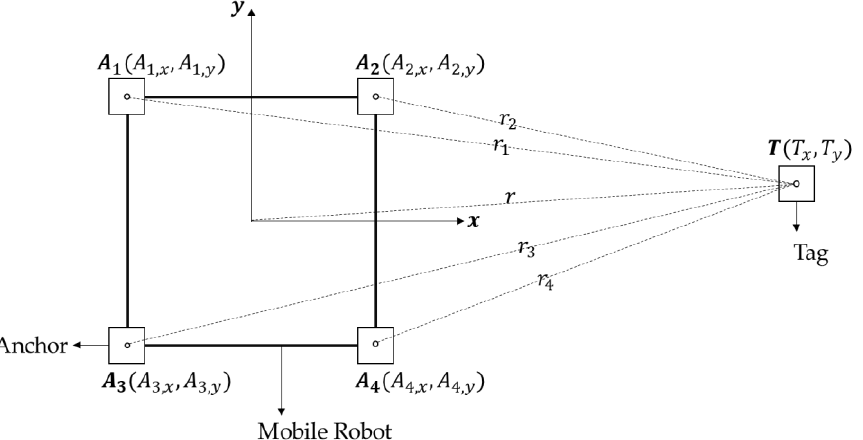
Figure 1. Overall configuration of UWB transceivers for the target localization.